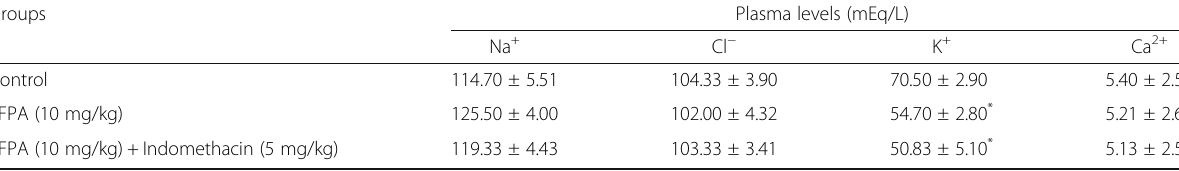
Table 3 Inhibitory effect of indomethacin on plasma electrolyte level induced by EFPA in rats Groups